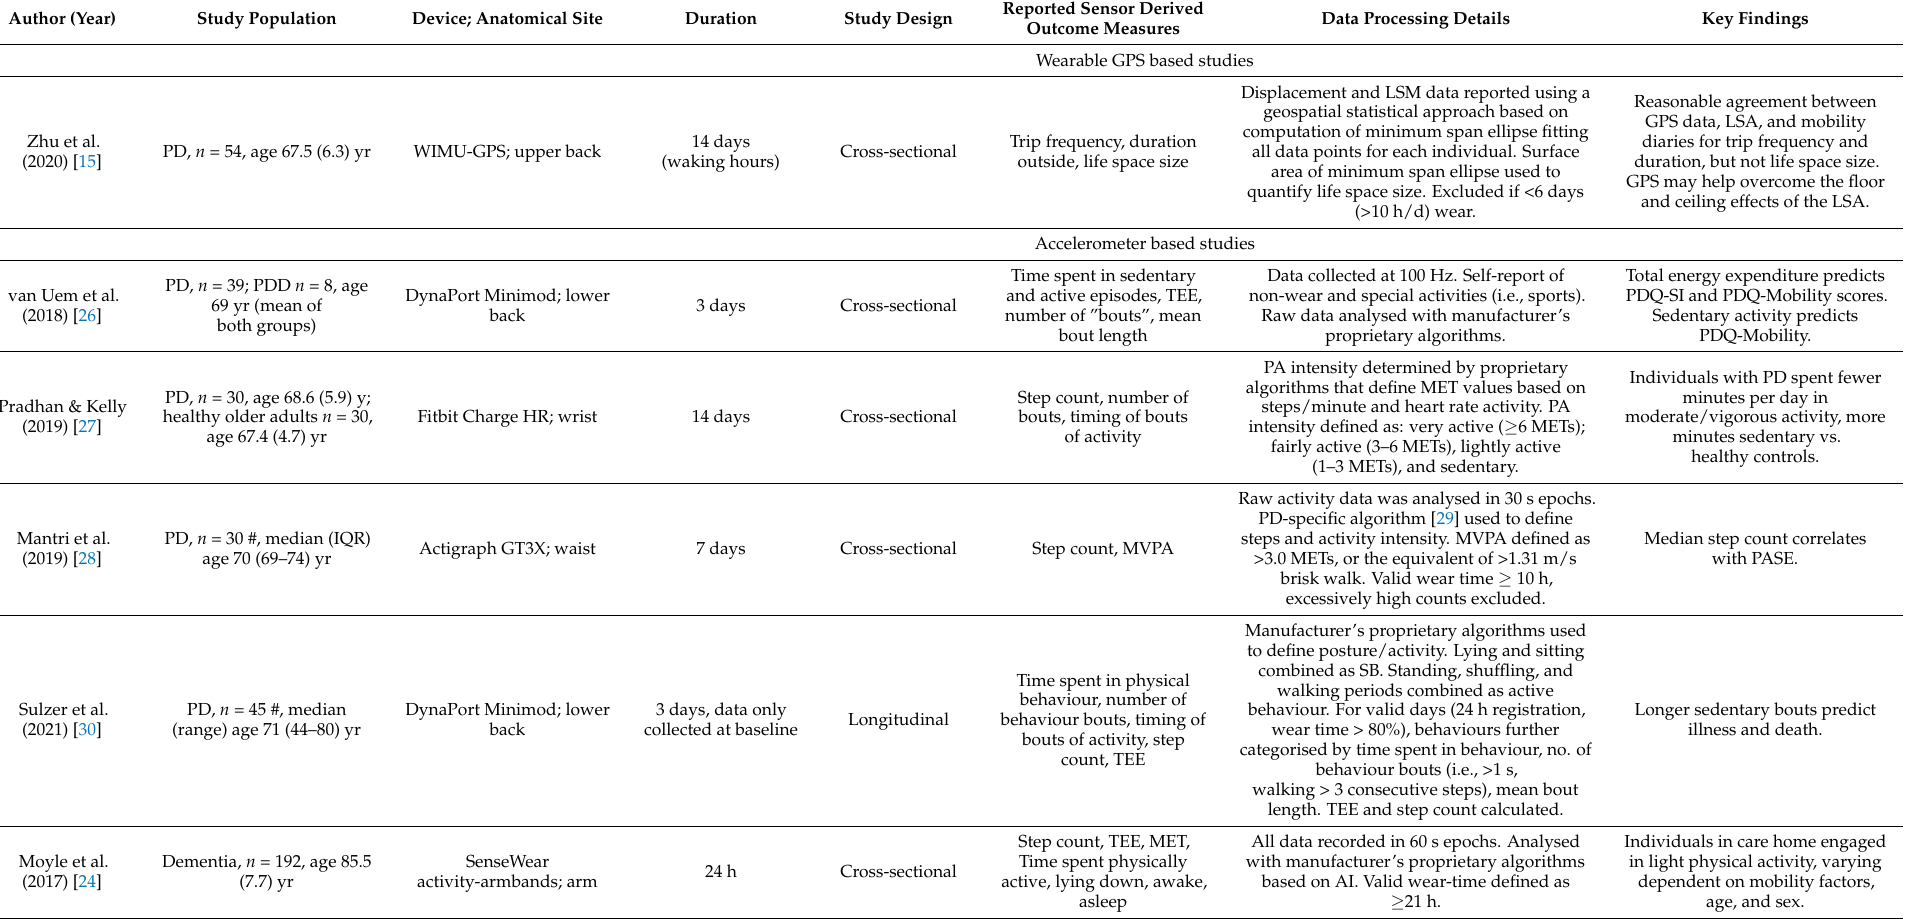
Table 1. Summary of identified papers where GPS and accelerometer devices have been used in patients with neurodegenerative disorders. Participant age is presented as mean (SD) where